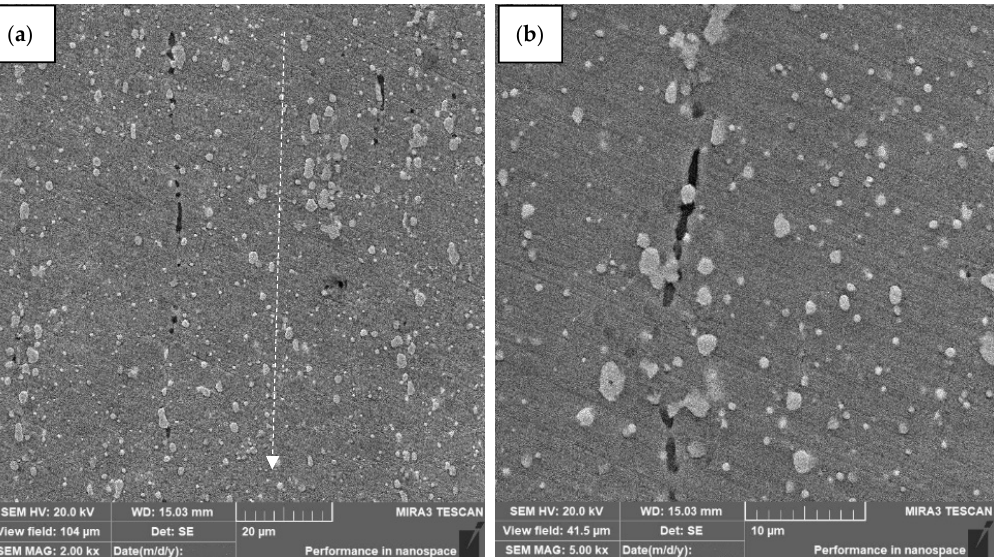
Figure 9. Qualitative analysis of the chemical composition of the W6Mo5Cr4V2 steel after dynamic alloying with SiC + Ni powder. Figure 10 shows the structure of W6Mo5Cr4V2 steel with channel elements after dy- namic alloying in the SDP mode by SiC + Ni stream and subsequent hardening.